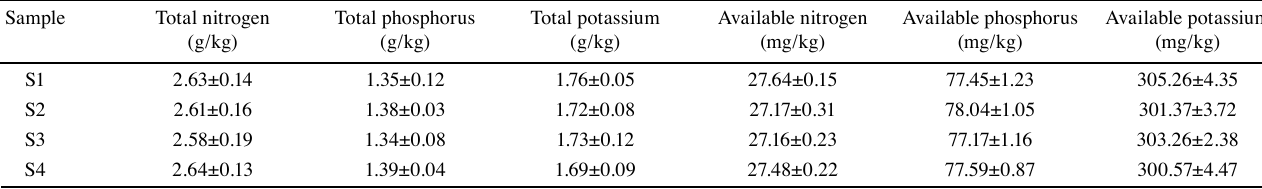
Tab. 1: Basic physicochemical indexes of tea plantation soils with different acidity. Sample